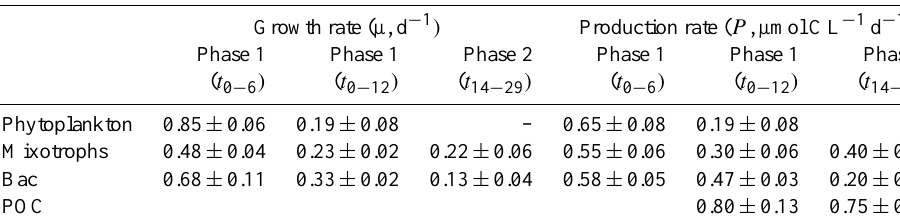
Table 1. Growth (µ) and production ( P ) rates based on Eqs. (1) and (3), respectively, for each phase. Values are presented as average of all mesocosms ± standard deviation ( n = 9).